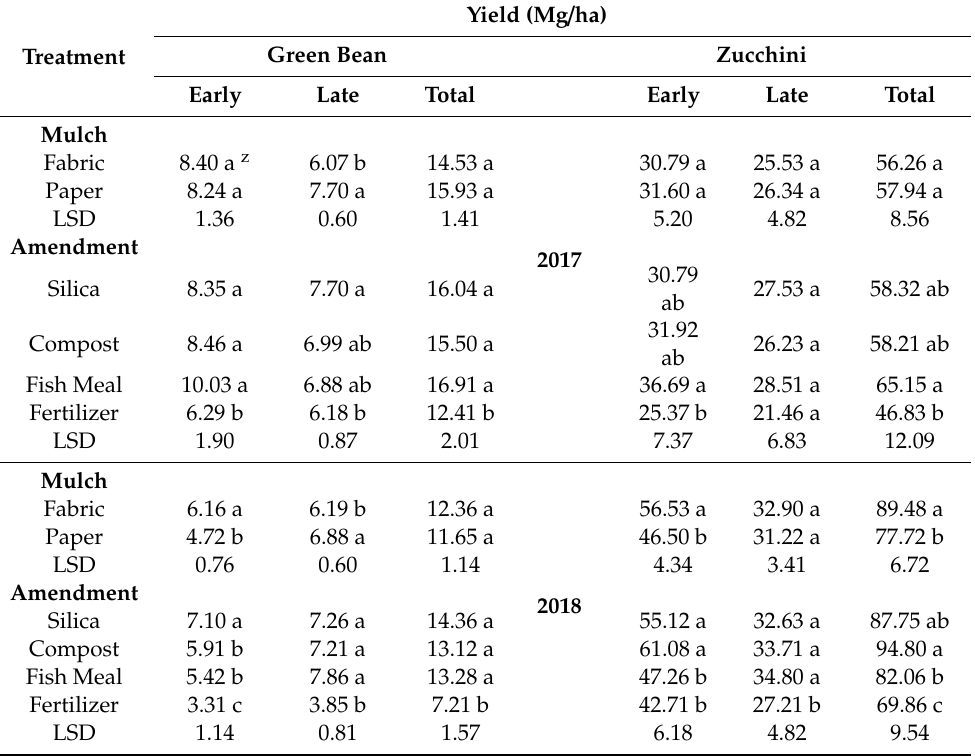
Table 6. Vegetable yield of green bean and zucchini, representing early yield (first 4 weeks), late yield (last 4 weeks), and total yield, as a ff ected by mulch type and soil amendments in 2017 and 2018 growing